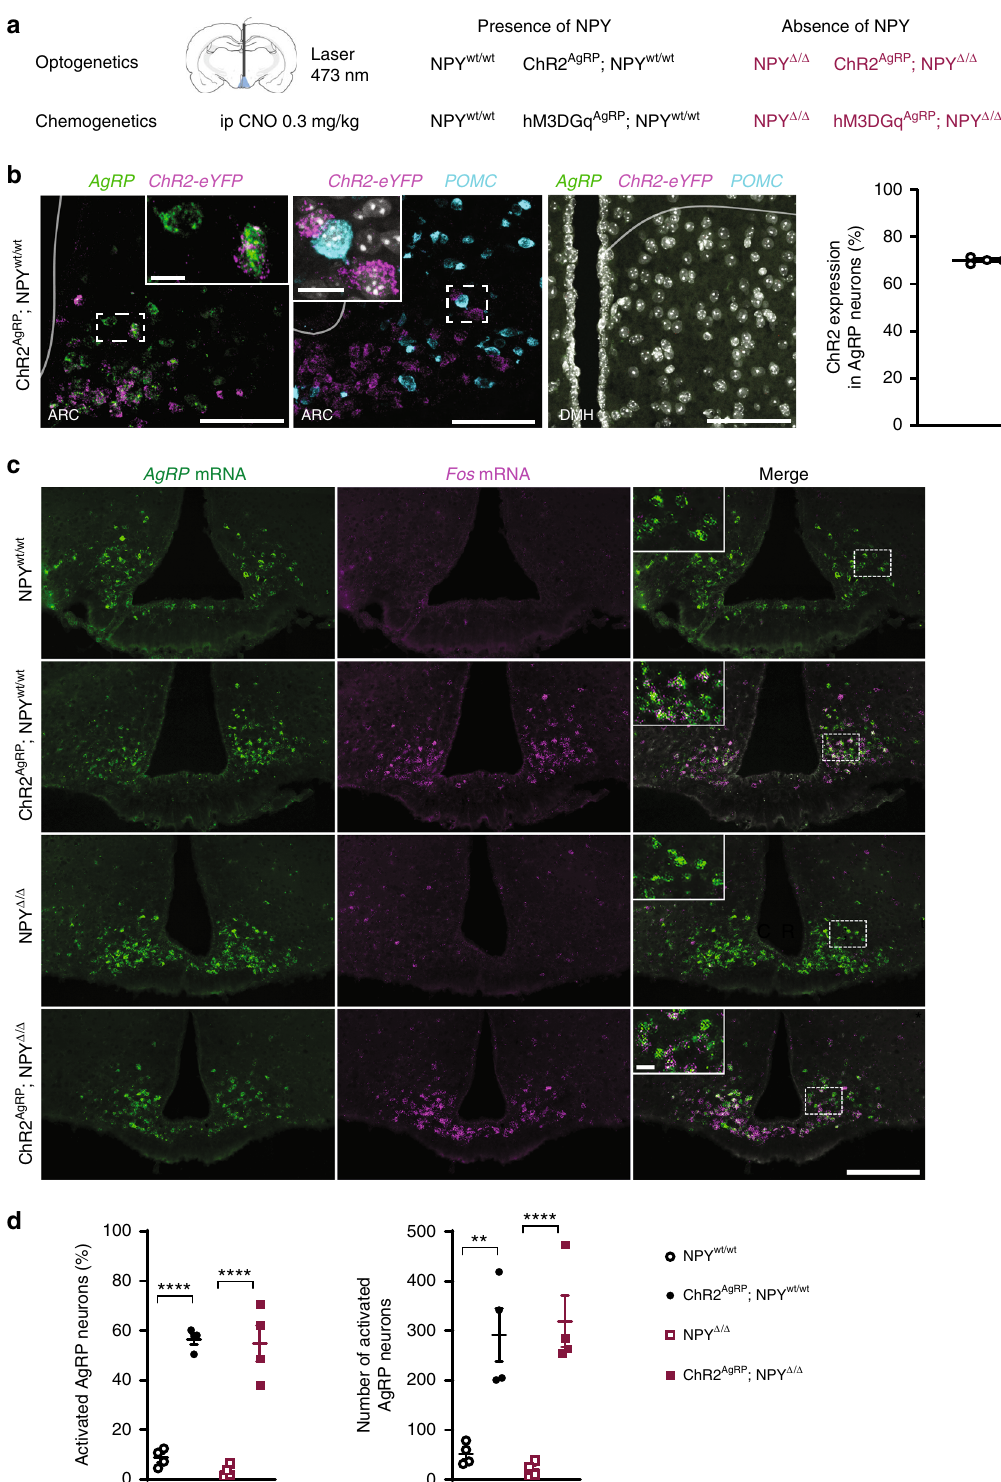
Fig. 1 NPY-de fi cient mice retain AgRP neuronal activation. a Schematic representation of the optogenetic and chemogenetic strategies used to activate AgRP neurons in NPY-expressing and NPY-de fi cient mice. b Expression of ChR2 occurs exclusively in AgRP neurons in the ARC. DAPI is depicted in gray in the DMH image ( n = 4 mice). c , d Optogenetic activation of AgRP neurons occurs to the same extent in mice with and without NPY expression ( n = 4 mice per group). Scale bar = 100 µ m in b , 200 µ m in c . Scale bars in insets = 20 µ m. Data are shown as mean ± s.e.m. Statistical analysis is represented by ** p ≤ 0.01 and **** p ≤ 0.0001 as determined by one-way ANOVA followed by Tukey post hoc test. Source data are provided as a Source Data fi